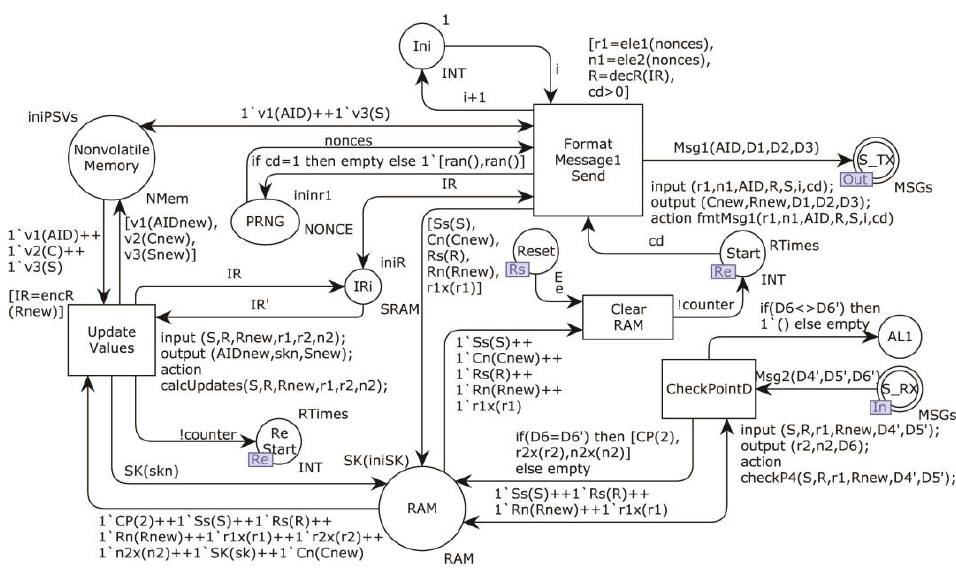
Figure 6. The Device model subpage.